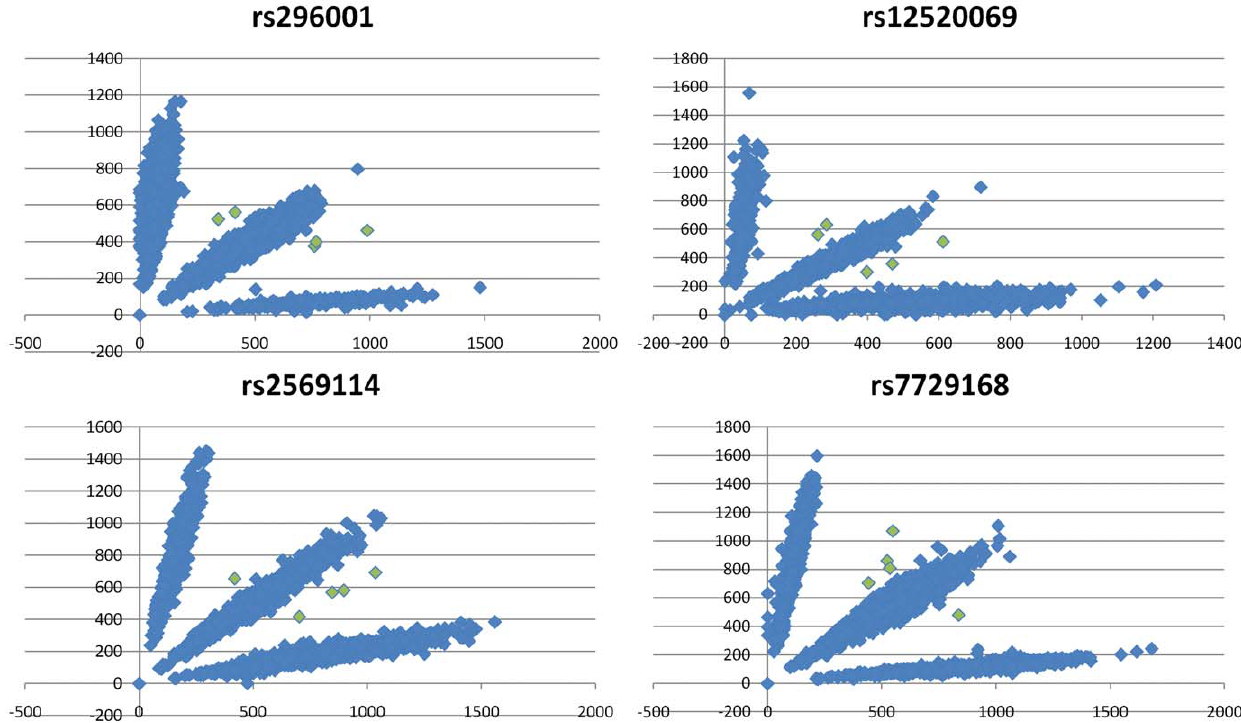
Figure 3. X and Y raw values showing common AA, AB, and BB states and rare AAB and ABB states. Raw Cartesian SNP Clusters with duplicated depression cases colored in green. Duplication AAB and ABB calls are found on multiple SNPs across the 5q35.1 region.